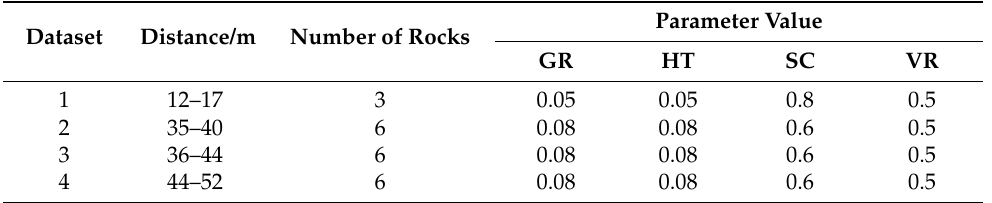
Table 2. Parameter description.